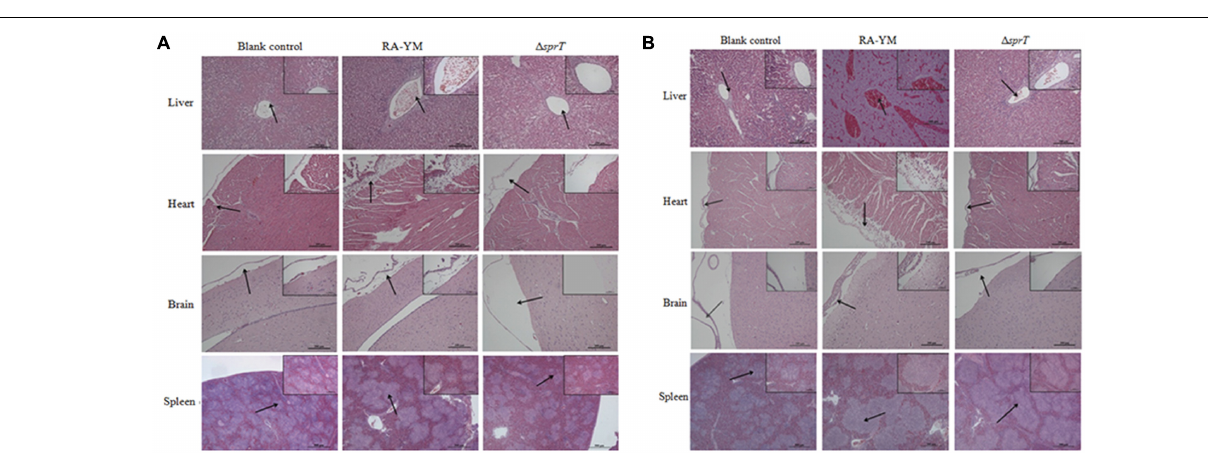
Frontiers in Microbiology |